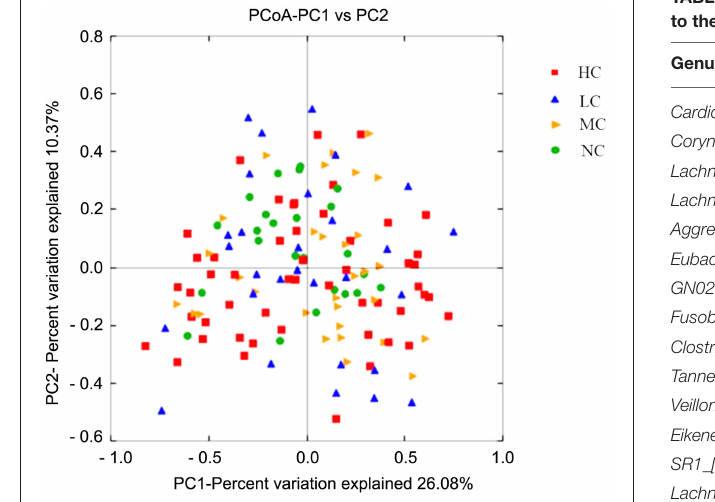
FIGURE 4 | PCoA based on the weighted UniFrac distances at the OTU level at 97% identity. Each sample is represented by a dot. Red squares represent the HC samples. Orange triangles represent the MC samples. Blue triangles represent the LC samples. Green balls represent the NC samples. PC1 explained 26.08% of the variation observed, and PC2 explained 10.37% of the variation. However, the samples did not form well-separated clusters corresponding to the four groups, suggesting that the bacterial structures in healthy and caries groups were similar.